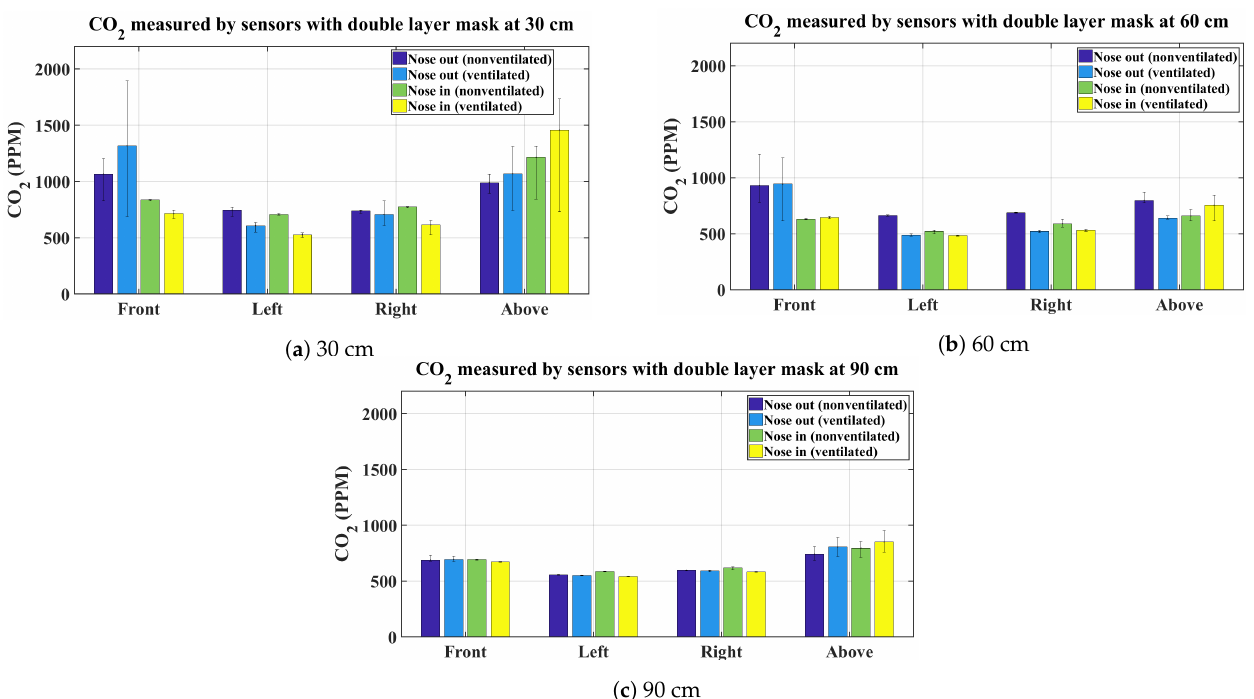
Figure 4. Average CO 2 measurements using a double layer